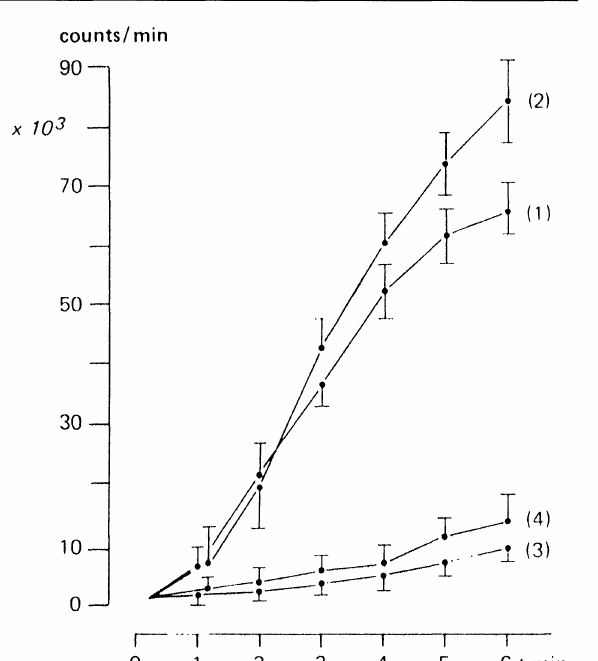
FIG. 1. Chemiluminescence measurement of isolated human PMNs in autologous plasma. The exposure to ZAP (curve as well as heated ZAP (curve 2) induces an increase generation of oxygen derived free radicals from the cells after 30 s. Native plasma (curve 3) does not result in increased metabolic activity. Plasma heating prior to zymosan incubation abolishes the generation of active complement fragments (curve